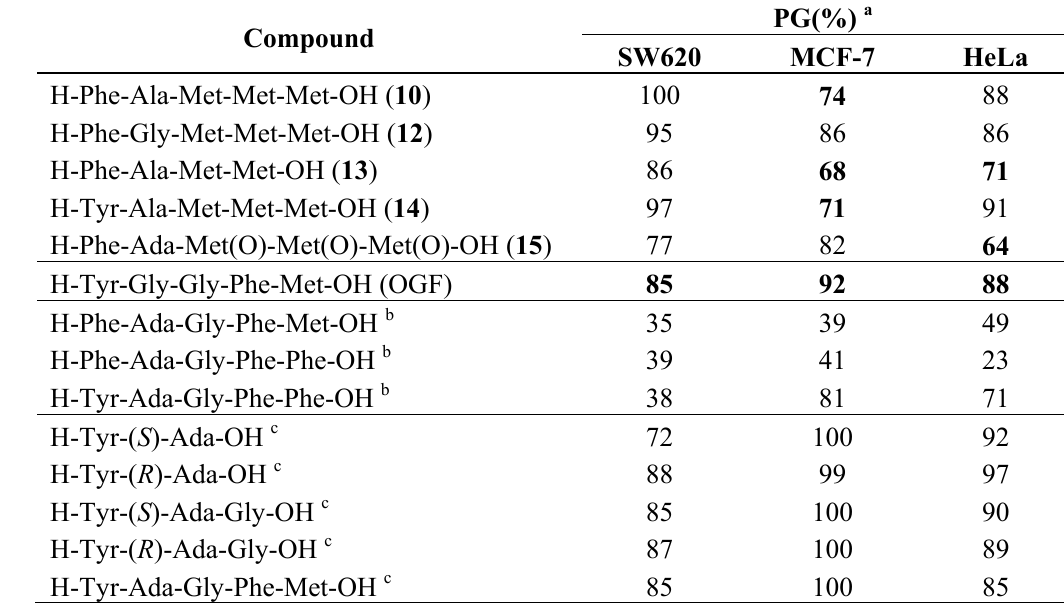
Table 3. Growth inhibition effects of OGF-related